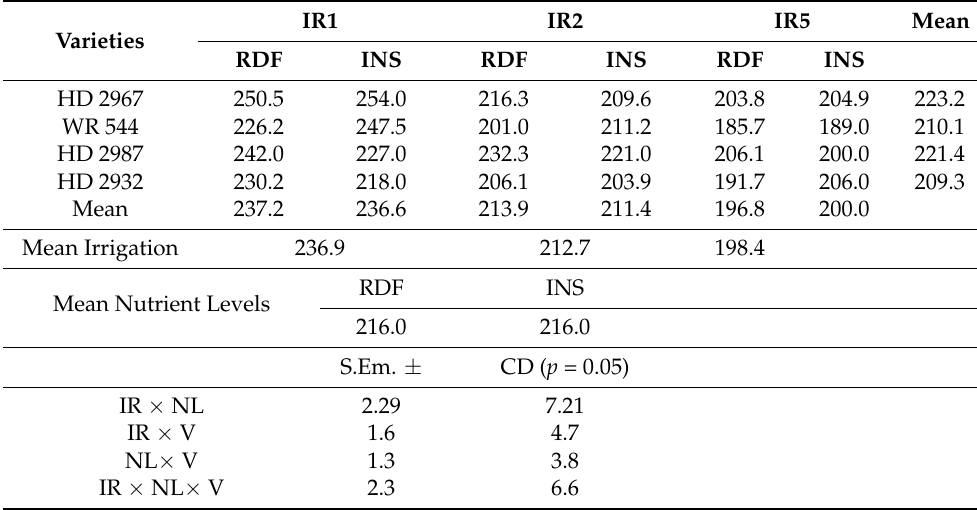
Table 2. Interaction effect of irrigation schedules and nutrient management levels and varieties on root length 50% flowering stage (cm).